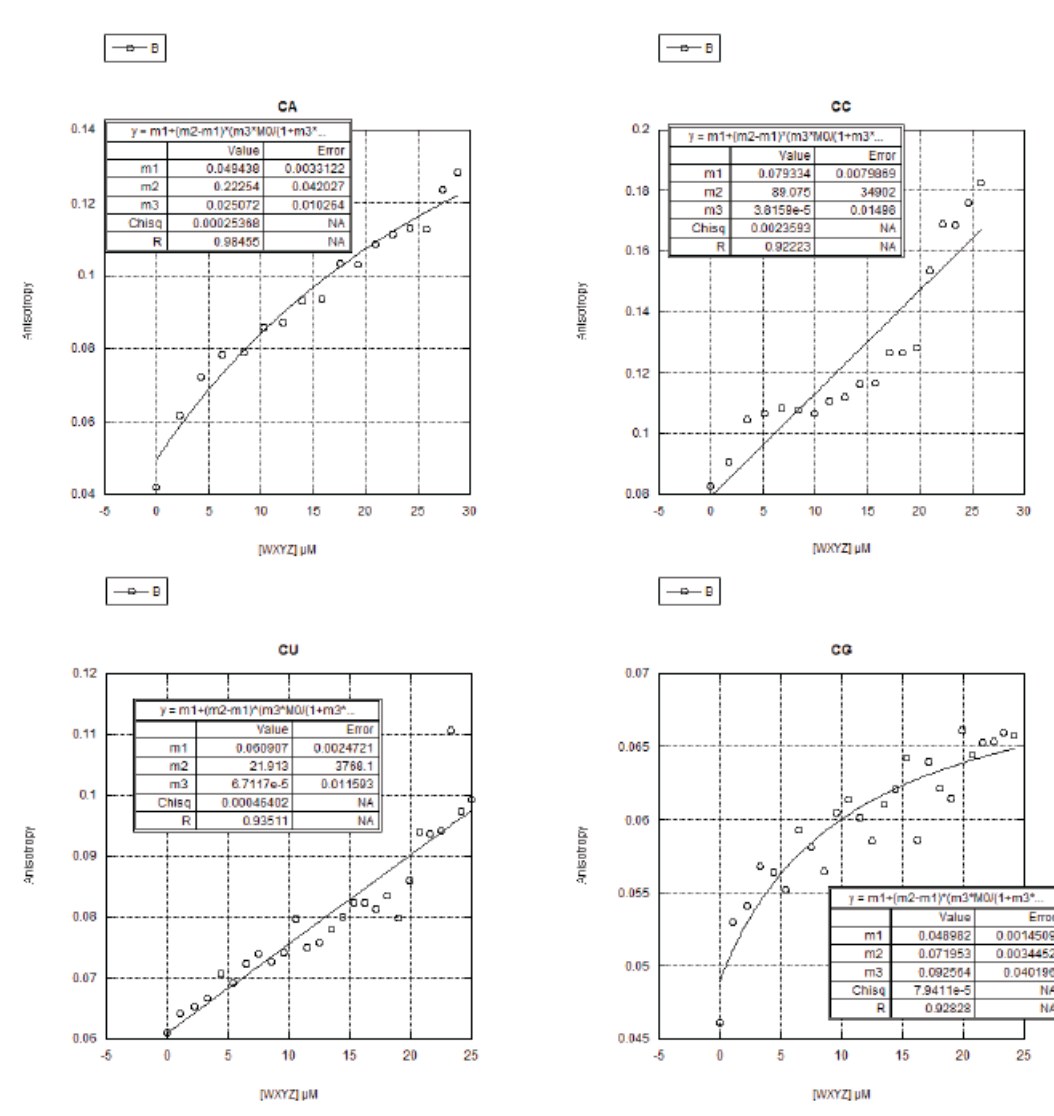
Figure A2. Raw anisotropy data for IGS-tag combinations where the middle nucleotide of the IGS is C. All of these plots show a saturation in polarization as RNA concentration increases.